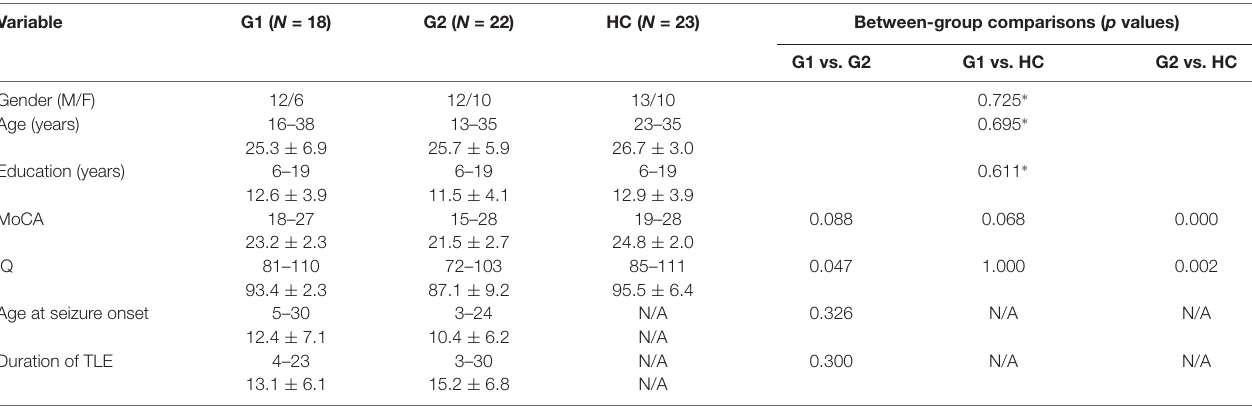
TABLE 1 | Group demographics and clinical information of all